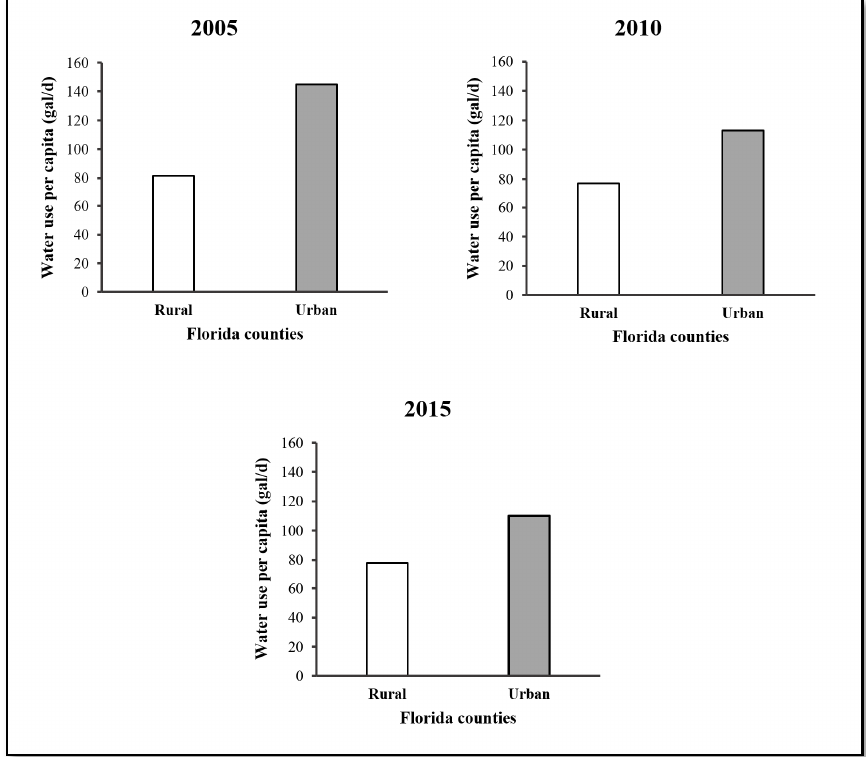
Figure 8. Rural and urban water use in 2005, 2010, and 2015.